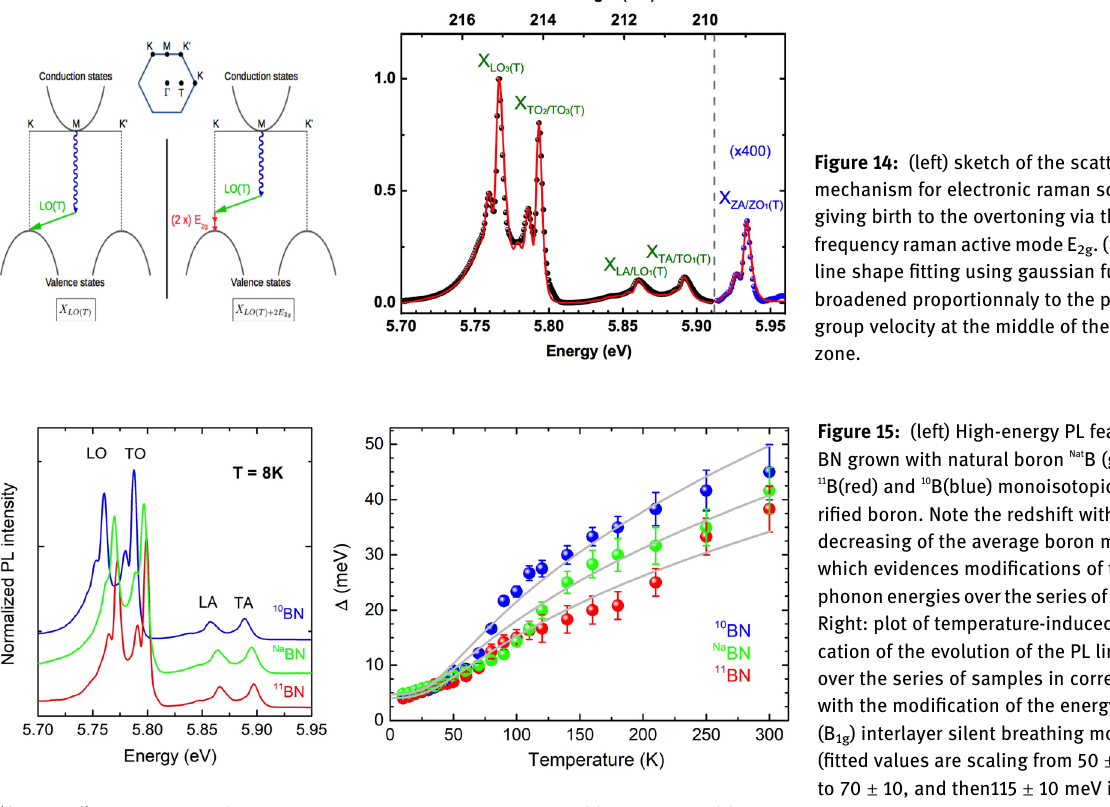
Nat BN and 10 BN, respectively) This fi gure is a reproduction of fi gures 2(a) and fi gure 4(b) in reference